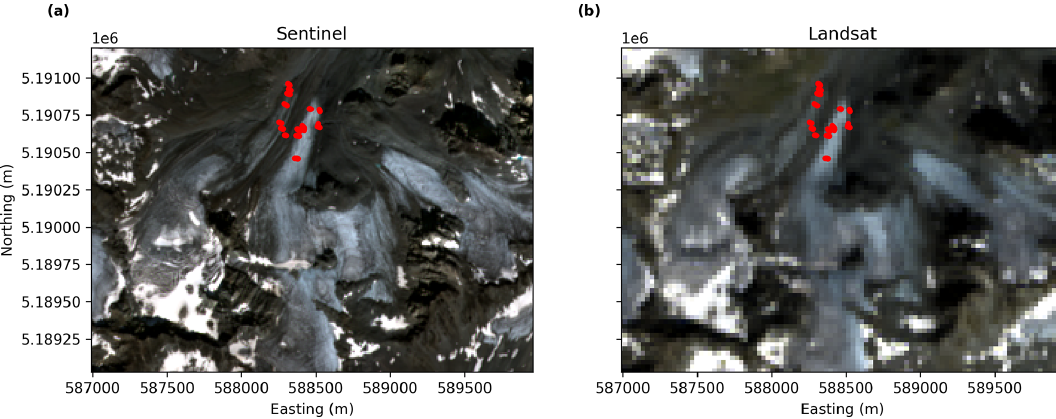
Figure 2. Jamtalferner as seen in the Sentinel (a) and Landsat (b) scenes used in this study. The images shown here are composites of bands 2, 3, and 4 of each satellite’s L2A surface reflectance product displayed at a resolution of 10 and 30m (Sentinel and Landsat, respectively) per pixel. Profiles where reflectance spectra were collected are marked in red. Coordinate reference system – EPSG:32632.